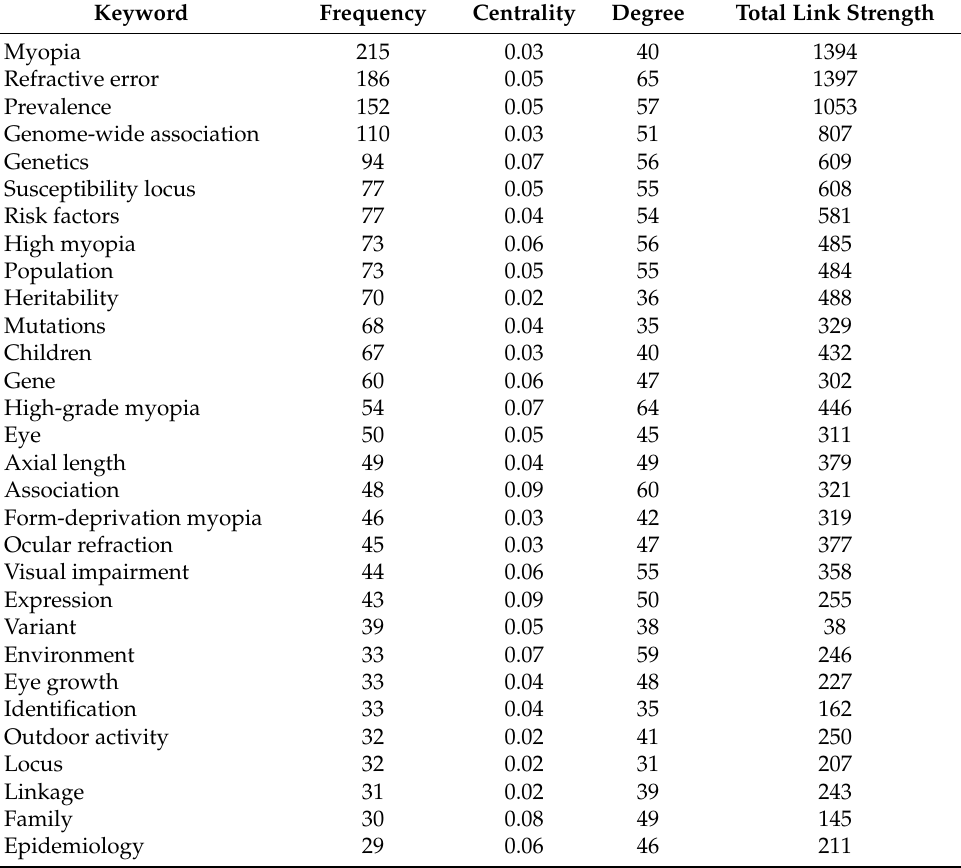
Table 6. The 30 most used keywords.